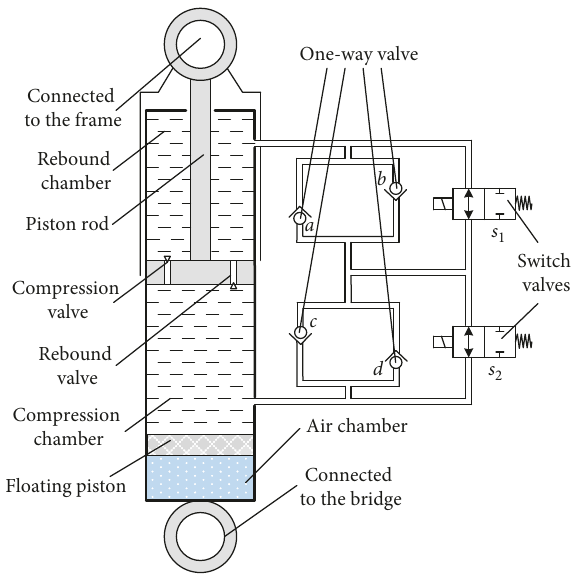
Figure 2: Structure of the shock absorber with multiple damping modes. Table 1: Four damping modes of the shock absorber. Damping